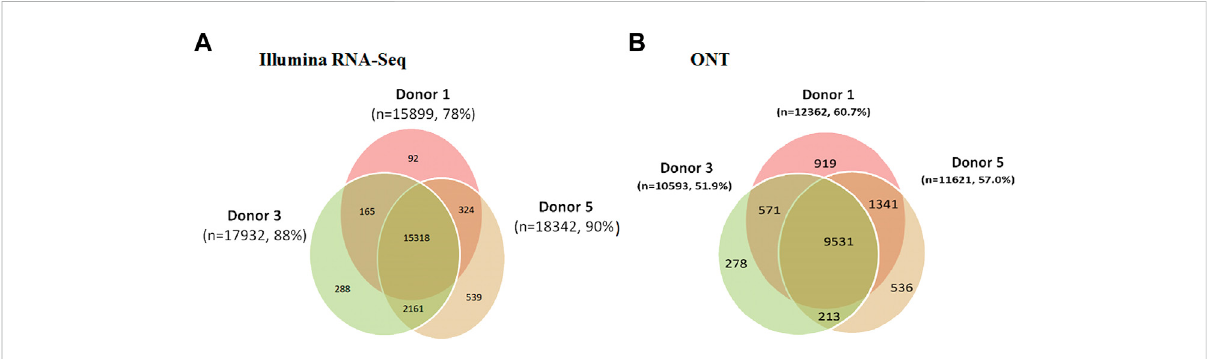
FIGURE 6 Results of the analysis of the three human liver tissue samples (donor 1, donor 3, and donor 5) indicating all transcripts detected using (A) Illumina RNA-Seq data (FPKM > 0) and (B) ONT (TPM > 0).